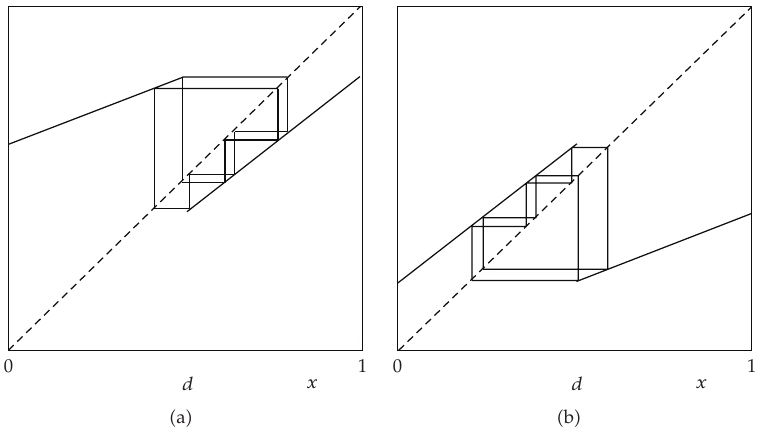
Figure 8: Discontinuous limiting map T 2 with (cid:2) a (cid:3) m L (cid:7) 1 − δ A (cid:7) 0 . 4, m R (cid:7) 1 − δ B (cid:7) 0 . 8, d (cid:7) 0 . 5; (cid:2) b (cid:3) m L (cid:7) 1 − δ A (cid:7) 0 . 8, m R (cid:7) 1 − δ B (cid:7) 0 . 4, d (cid:7) 0 .